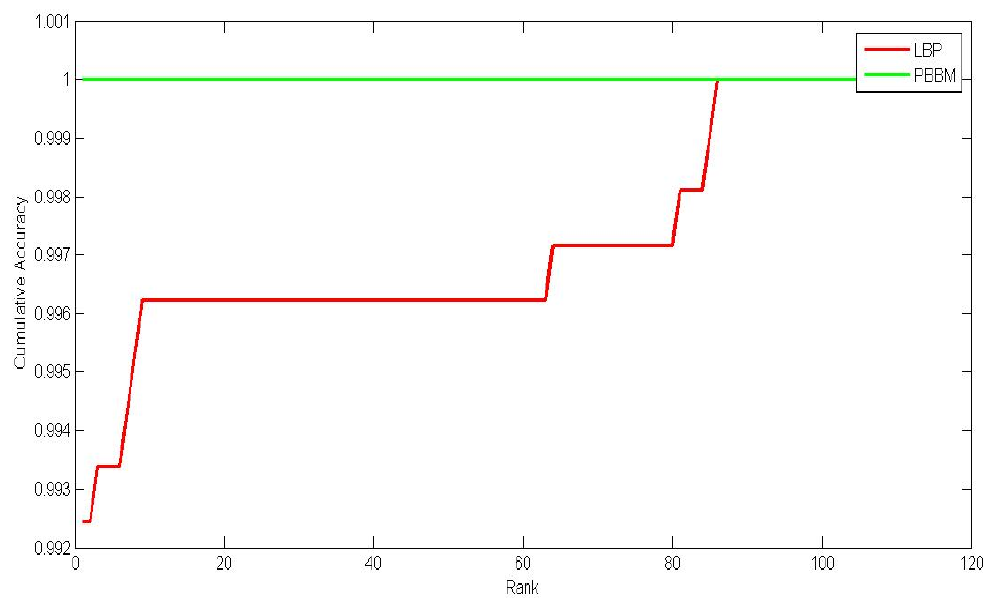
Figure 10. Cumulative match curves by different methods.